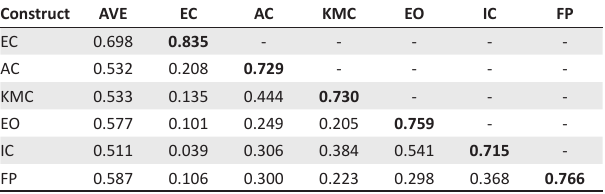
TABLE 4: Square root of average variance extracted and inter-construct correlation. Construct